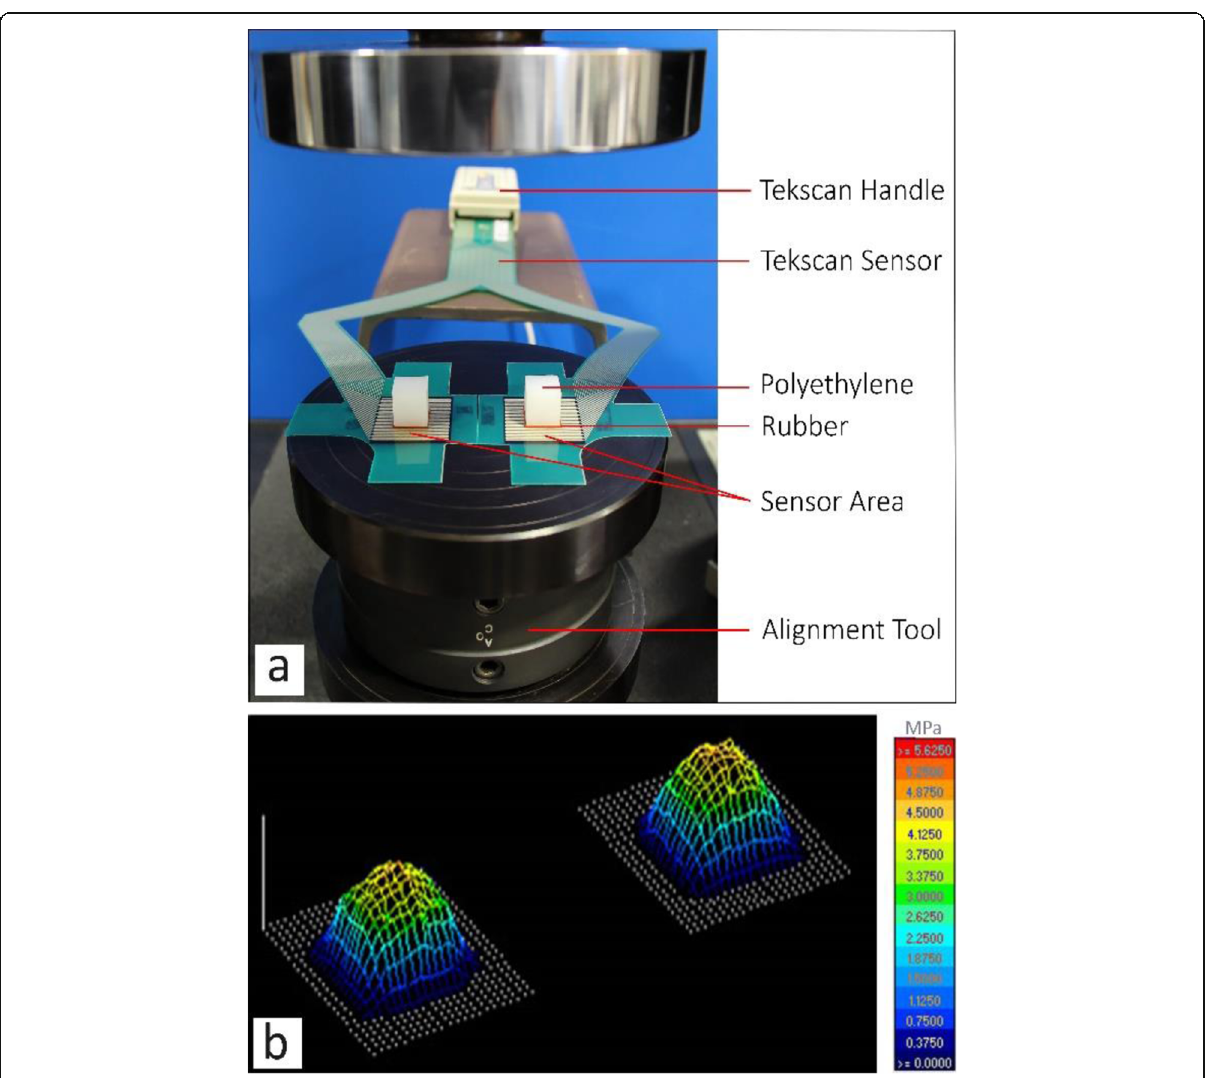
Fig. 6 a sensor calibration setup, b graphic representation of pressure distributions during the calibration